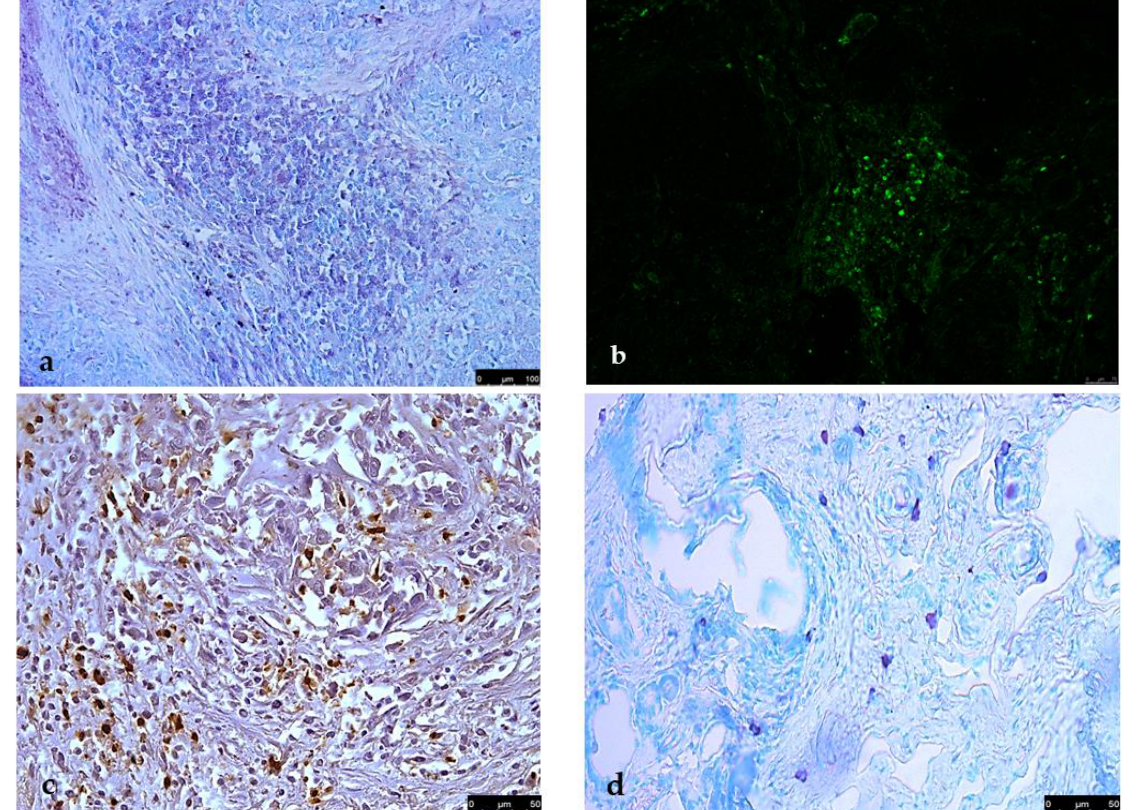
Figure 2. Stromal infiltrates mainly composed of T lymphocytes (( a ), CD3, Vector Vip, 5 × ) with a minimal representation of plasma cells (( b ), IgG, FITC, 10 × ). Macrophages, numerous, scattered and independent of the lymphoplasmacytic infiltrates (( c ), MAC/387, DAB, 20 × ). Mast cells, in hyperplastic/dysplastic areas (( d ), MC tryptase, Vector Vip, 10 × ). Only in high-grade carcinomas, in the peritumoral stroma, inflammatory